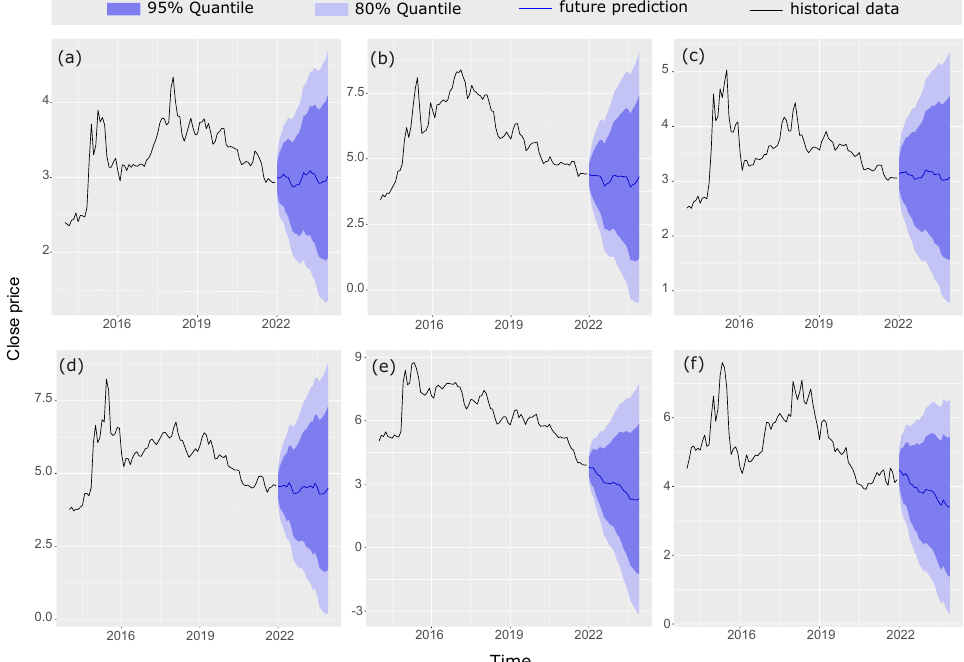
Figure 7. The output of timeseries prediction for all six portfolios including ( a ) Stock 1; ( b ) Stock 2; ( c ) Stock 3; ( d ) Stock 4; ( e ) Stock 5; ( f ) Stock